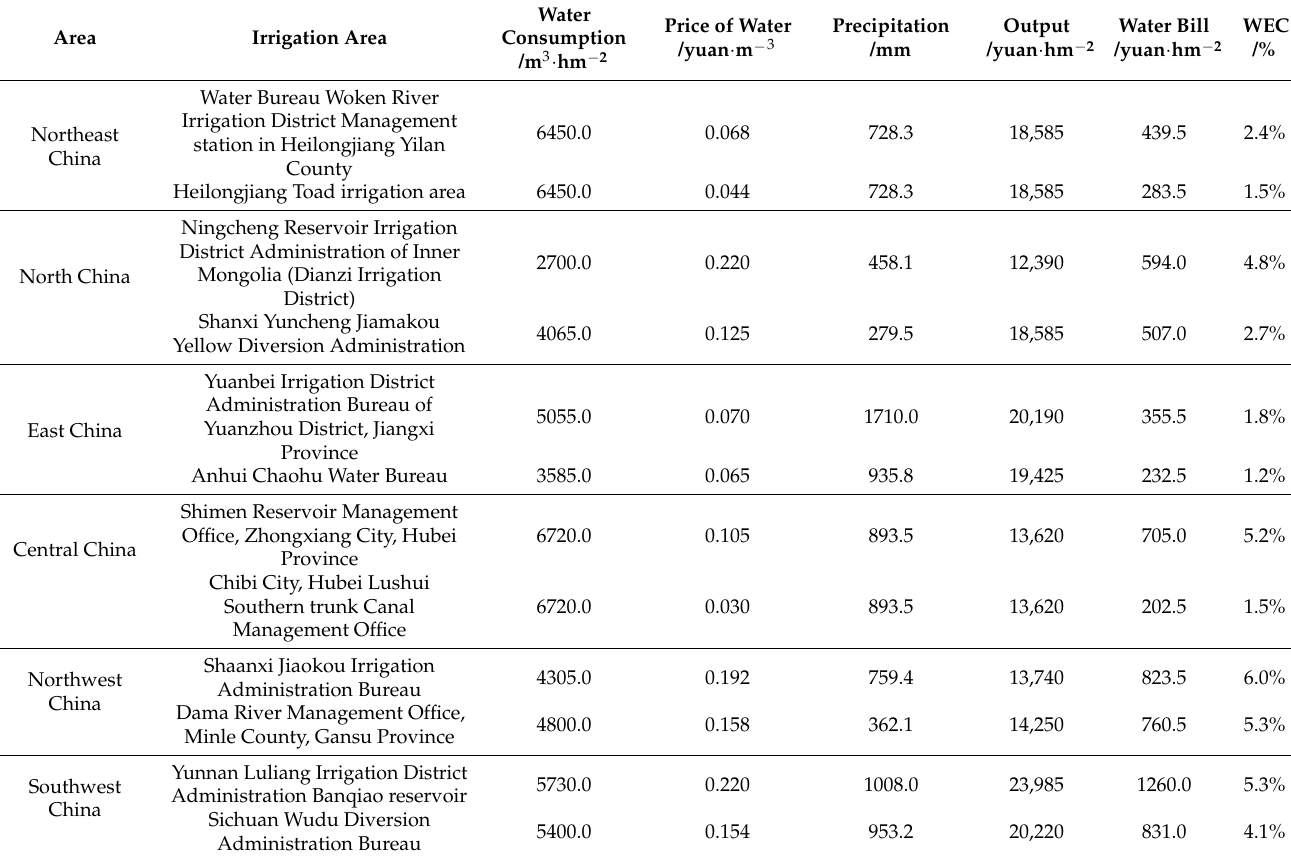
Table 11. Water price and WEC for typically irrigated areas in each region with high water